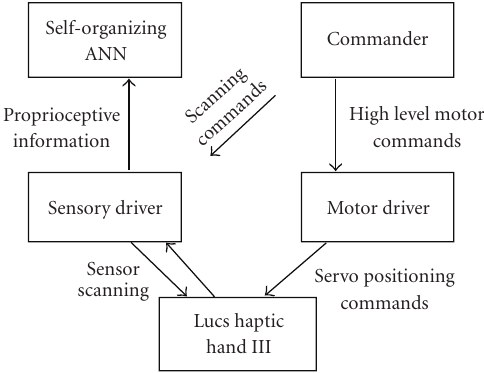
Figure 3: Schematic depiction of the systems. The commander module executes the grasps by sending high-level motor commands to the motor driver, which translates and conveys the information to the servo controller board of the robot hand. When the robot hand has become fully closed around the object, the commander module requests a scanning of the 11 proprioceptive sensors of the robot hand. The sensory information is conveyed as a vector to a Self- Organizing ANN (SO-ANN). The SO-ANN is a Self-Organizing- Map, a Growing Cell Structures, a Growing Cell Structures with Deletion of Neurons, or a Growing